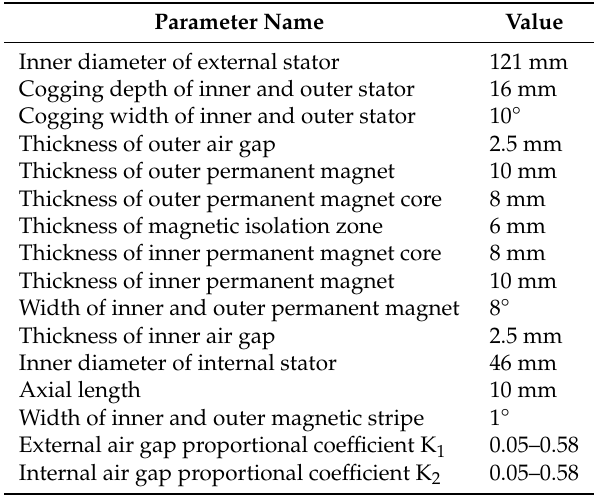
Table 1. Structural parameters of three-dimensional model of the PMSM.